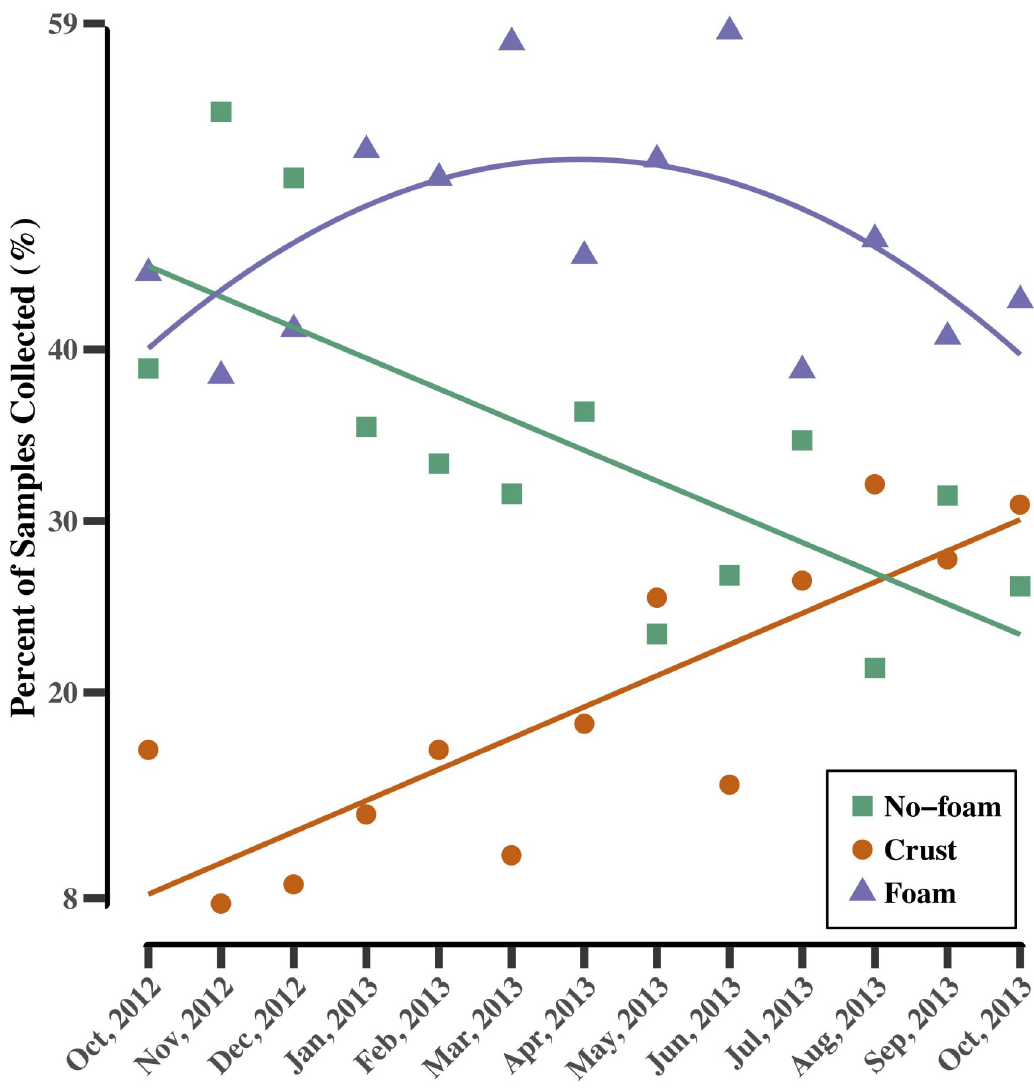
Fig 1. The proportions of manure samples with different surface textures collected over 13 months, where “no-foam” represents non-foaming manure, “crust” represents crust-forming manure, and “foam” represents foaming manure. The lines are the fitted trend lines showing the changes in percent of different type of samples collected over the